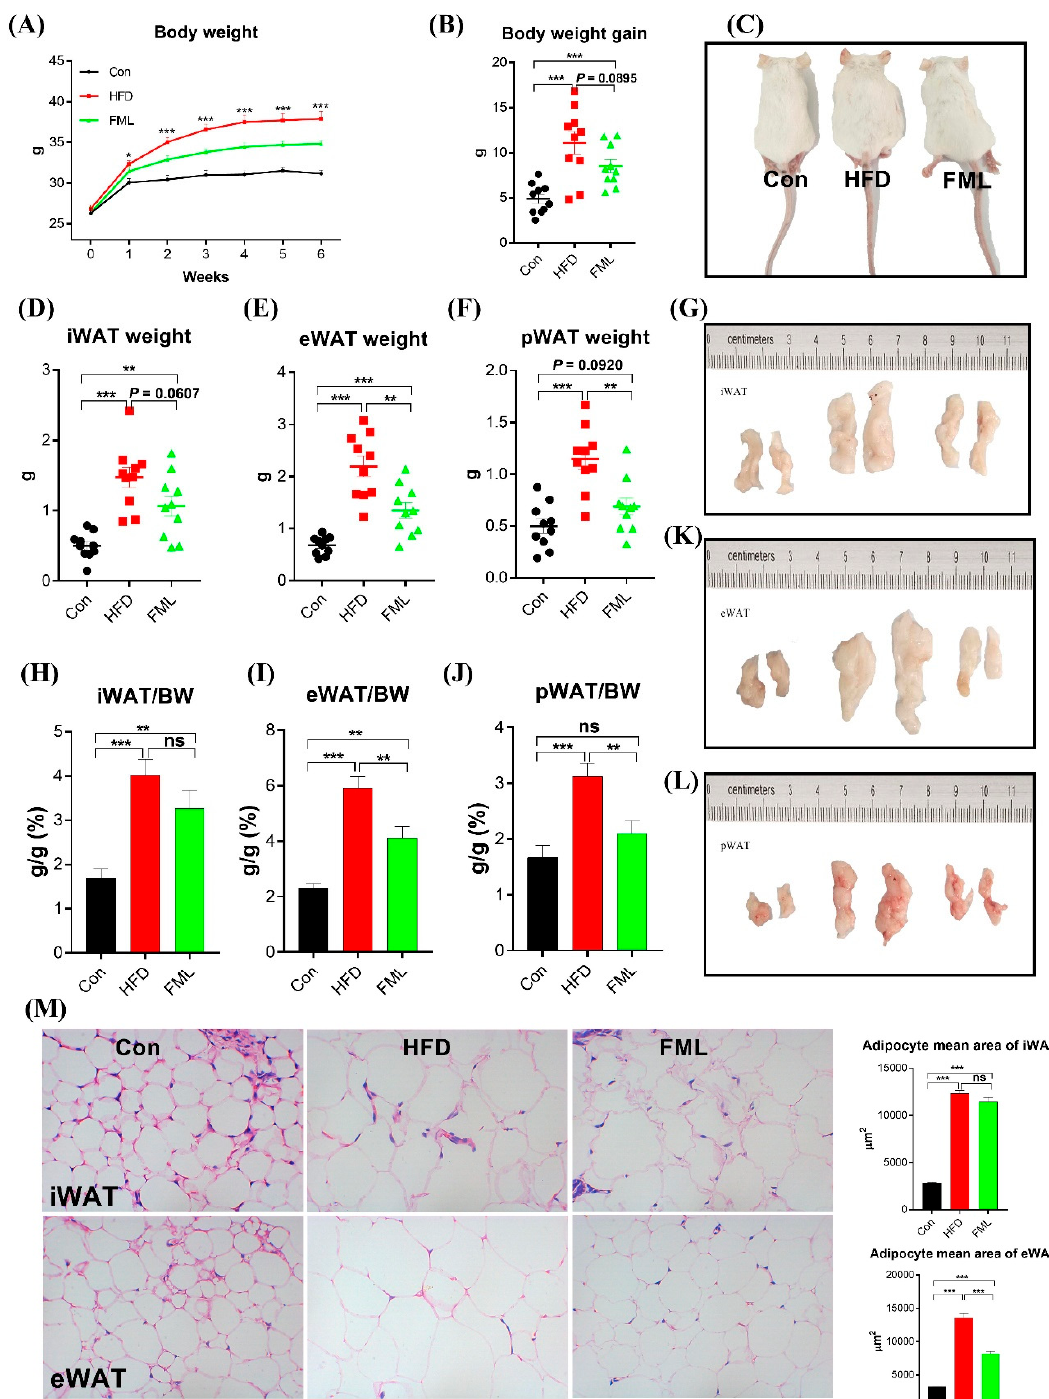
Figure 1. Flavonoids from mulberry leaves (FML) administration reduced body weight gain in HFD-fed mice. FML administration. ( A ) Body weight, ( B ) body weight gain, ( C ) representative mice, ( D ) inguinal white adipose tissues (iWAT weight), ( E ), epididymal white adipose tissue (eWAT weight), ( F ) perirenal white adipose tissue (pWAT weight), ( G ) representative iWAT, ( H ) iWAT / BW ratio, ( I ) eWAT / BW ratio, ( J ) pWAT / BW ratio, ( K ) representative eWAT, ( L ) representative pWAT, ( M ) H&E staining of iWAT and eWAT sections ( × 400) in female ICR mice fed a control diet (Con), high fat diet (HFD), or HFD with FML (FML) administration ( n = 10) for six weeks. Data are presented as mean ± SEM, di ff erences were denoted as follows: * p < 0.05, ** p < 0.01, *** p < 0.001; ns p > 0.05.